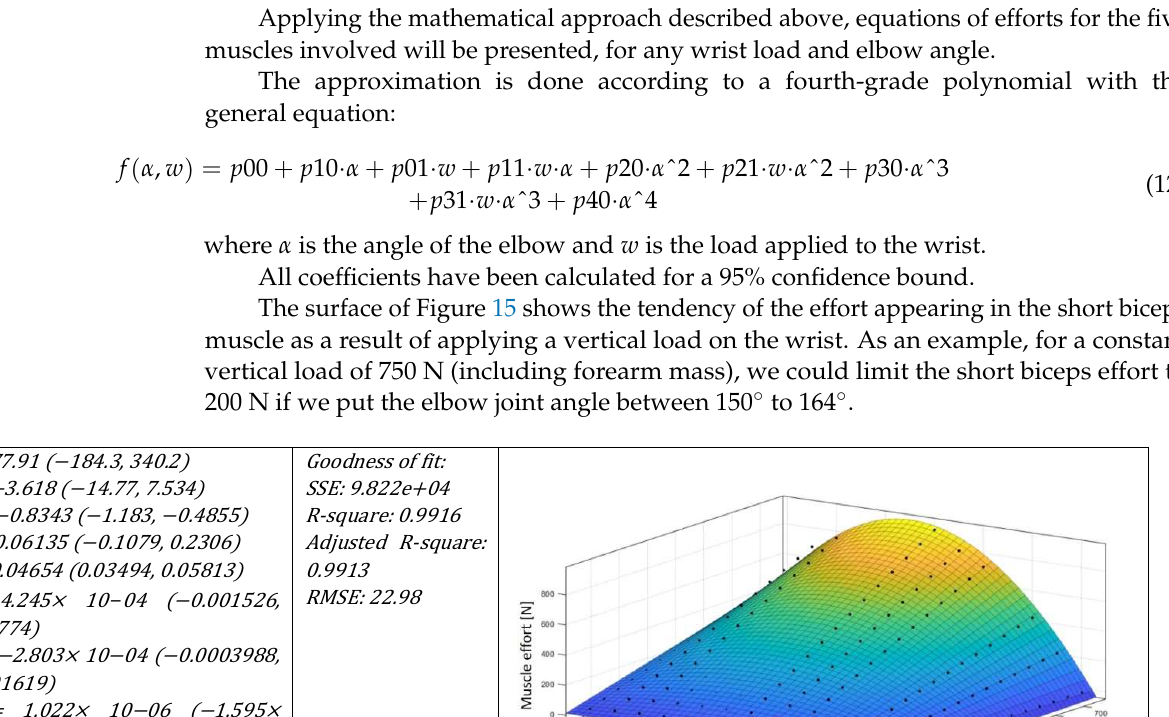
Figure 14. Comparison of the (continuous line) calculated and (dash point line) comparison, for triceps forces (Y-axis). Isometric contractions on the elbow at different positions, from 44 to 164 de- grees (X-axis) and 150 N are loaded on the wrist.